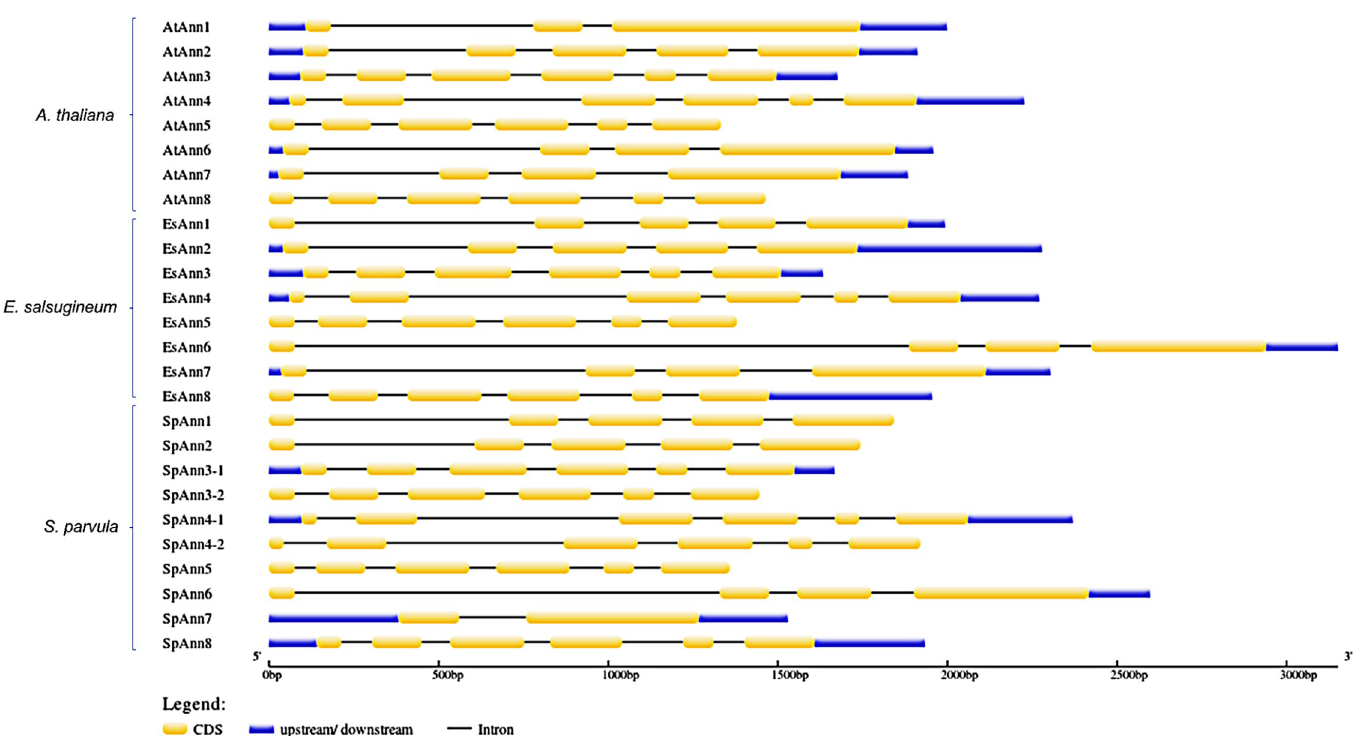
Fig 2. Gene structure of Ann genes in A . thaliana , S . parvula and E . salsugineum